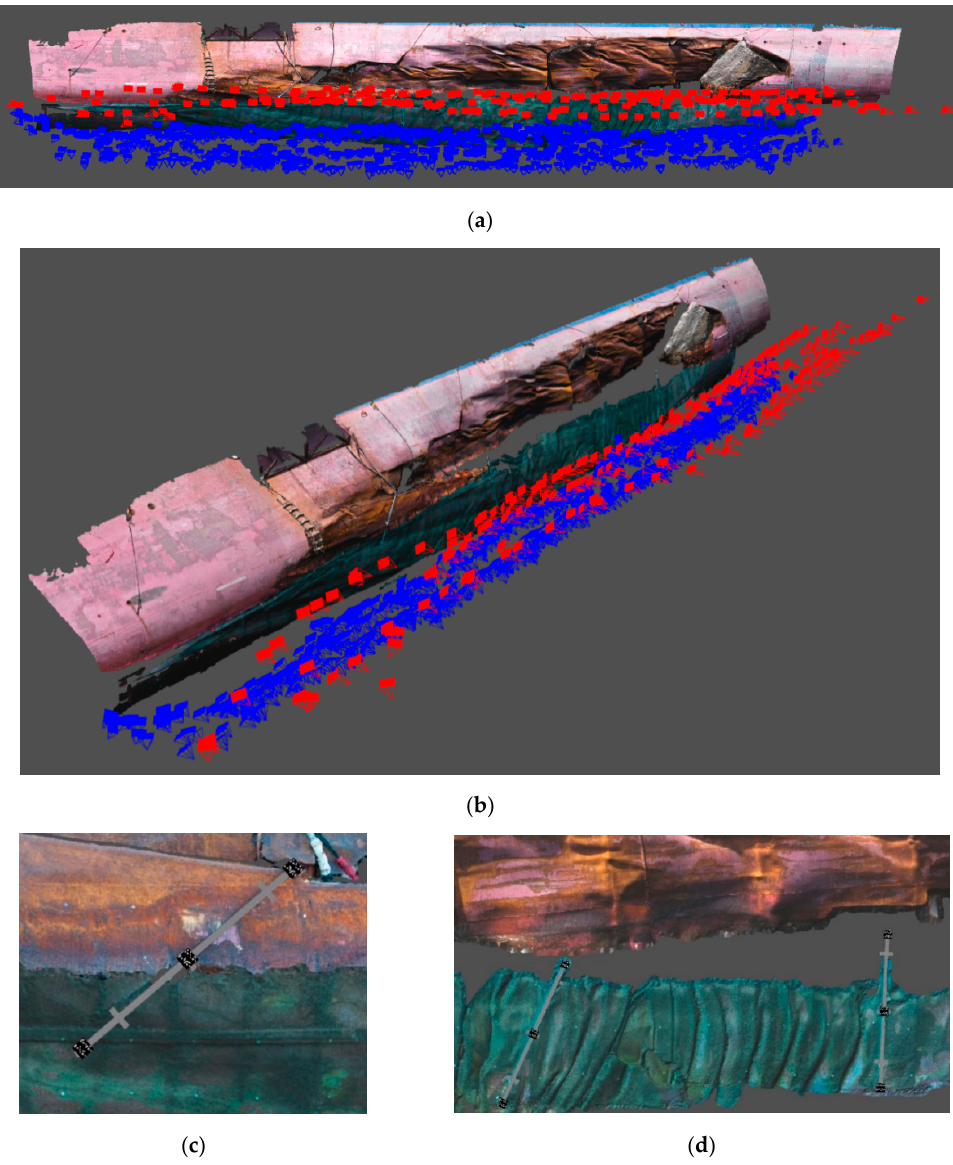
Figure 14. Alignment of all the ODs on the above-the-water ( a ) and underwater ( d ) photogrammetric models. ( b ) and ( c ) show particulars of the alignment of OD-F.